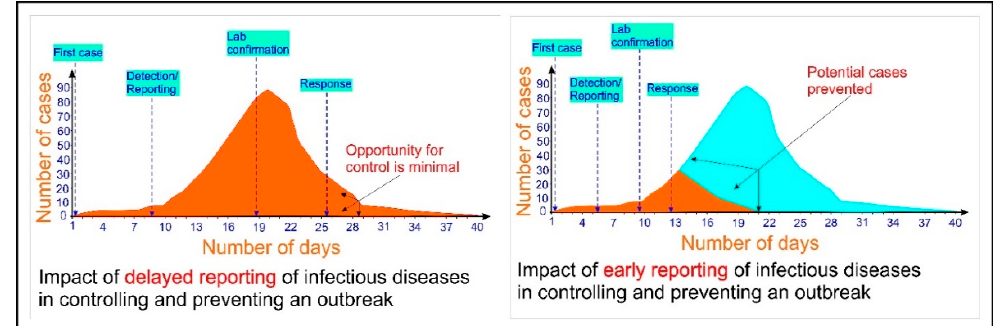
Figure 2. The dramatic impact of the rapid detection of infectious diseases in controlling and preventing an outbreak (adapted to WHO document [18] and References [19,20]).